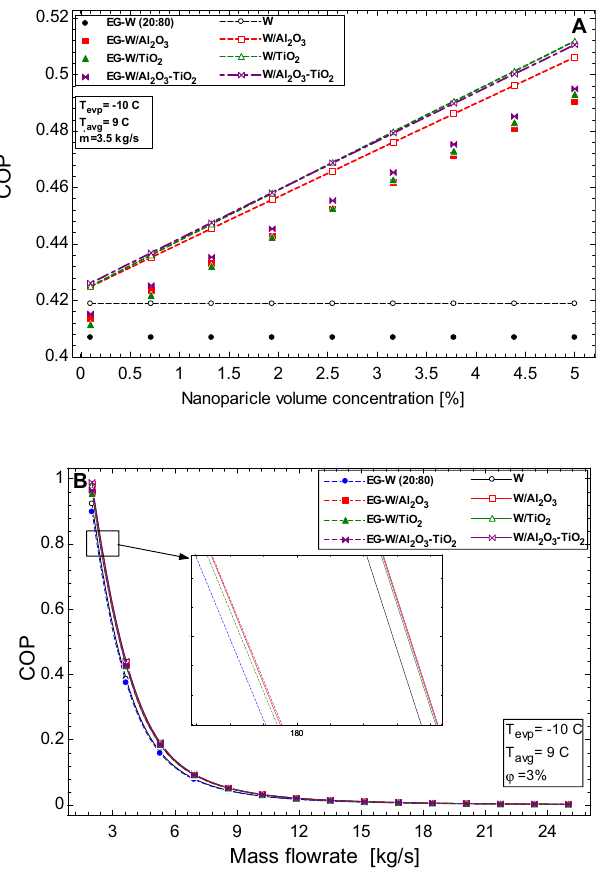
Figure 9. Effect of ( A ) nanoparticle volume concentration and ( B ) mass flow rate of working fluids on the COP of the